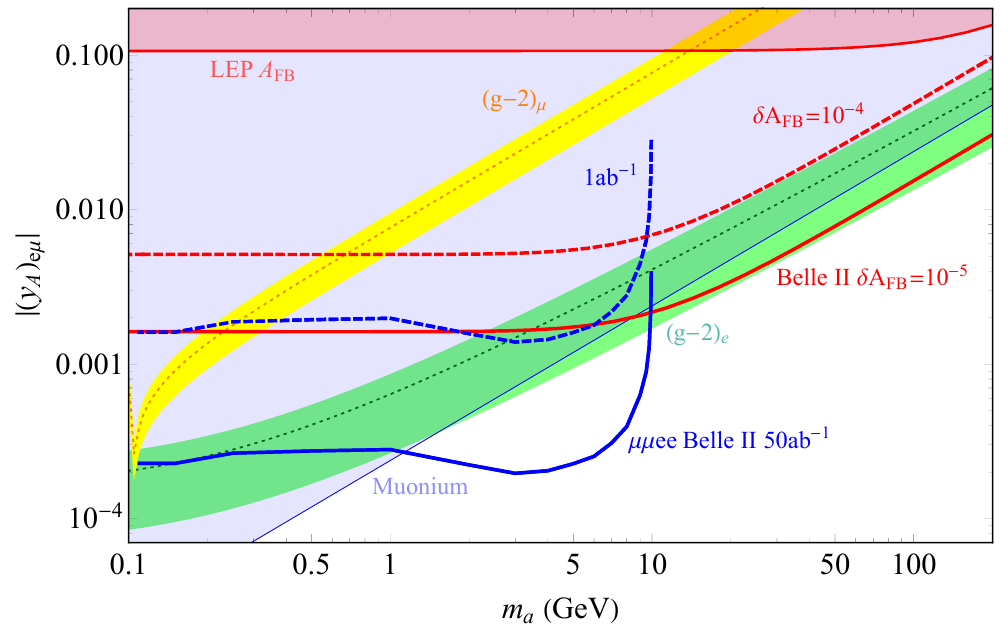
Figure 5 . The Belle II sensitivities are shown with ( y V ) e(cid:22) = 0 (cid:12)xed. The dashed and solid red lines represent the sensitivity of the A FB measurement with resolutions of (cid:14)A FB = 10 (cid:0) 4 and 10 (cid:0) 5 , respec- tively. The dashed and solid blue lines represent the sensitivity of searching for e + e (cid:0) ! (cid:22) (cid:6) (cid:22) (cid:6) e (cid:7) e (cid:7) with the integrated luminosity of 1 and 50 ab (cid:0) 1 , respectively. In the green and yellow regions, (cid:1) a e and (cid:1) a (cid:22) are explained within the 2 (cid:27) level with the central value drawn by the green and orange dotted lines, respectively. The blue-shaded region is excluded by the M{M oscillation at the 90% CL. The red-shaded region is excluded by the LEP measurement of A FB